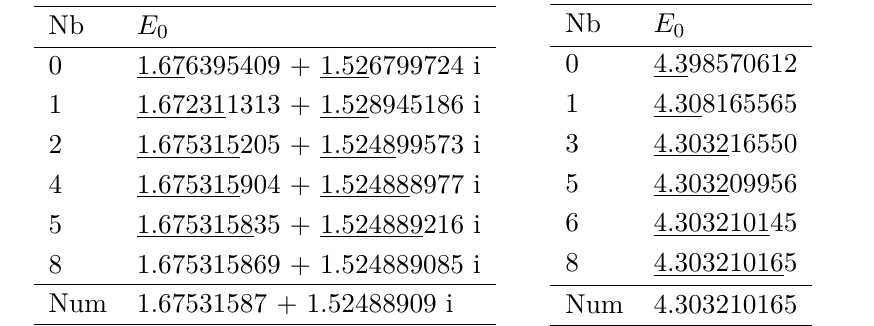
Table 5 . First energy level of (8.11) for ~ = 1 , m = 1 / 20 , Λ = 1 (left) and ~ = 1 , m = 2i , Λ = e − i π/ 6 (right). Nb denotes the order at which we truncate the instanton counting expression (6.1). The numerical value in the last line is obtained by using numerical diagonalization of the